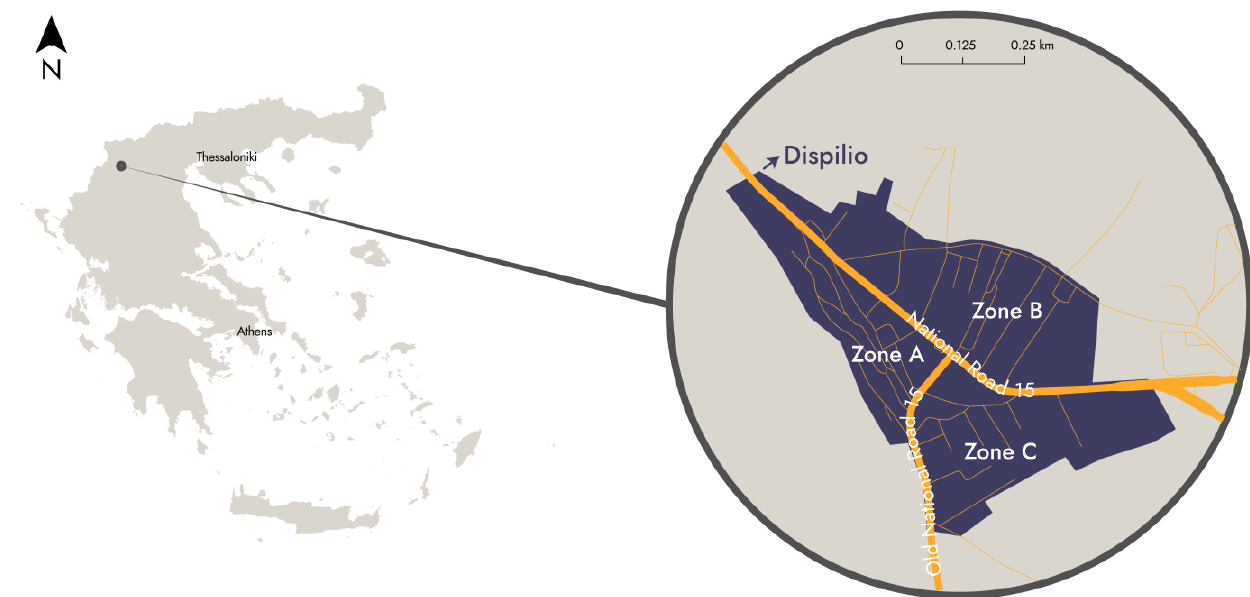
Figure 5. The settlement of Dispilio.